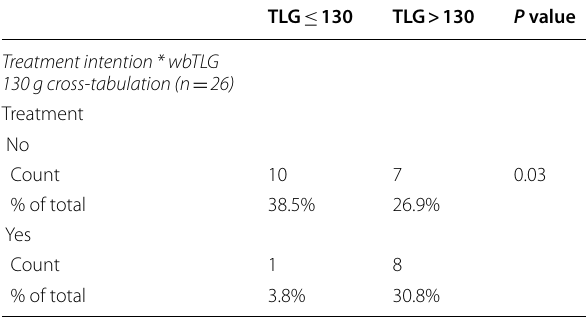
Table.10 Outcome according to wbTLG 130 g and